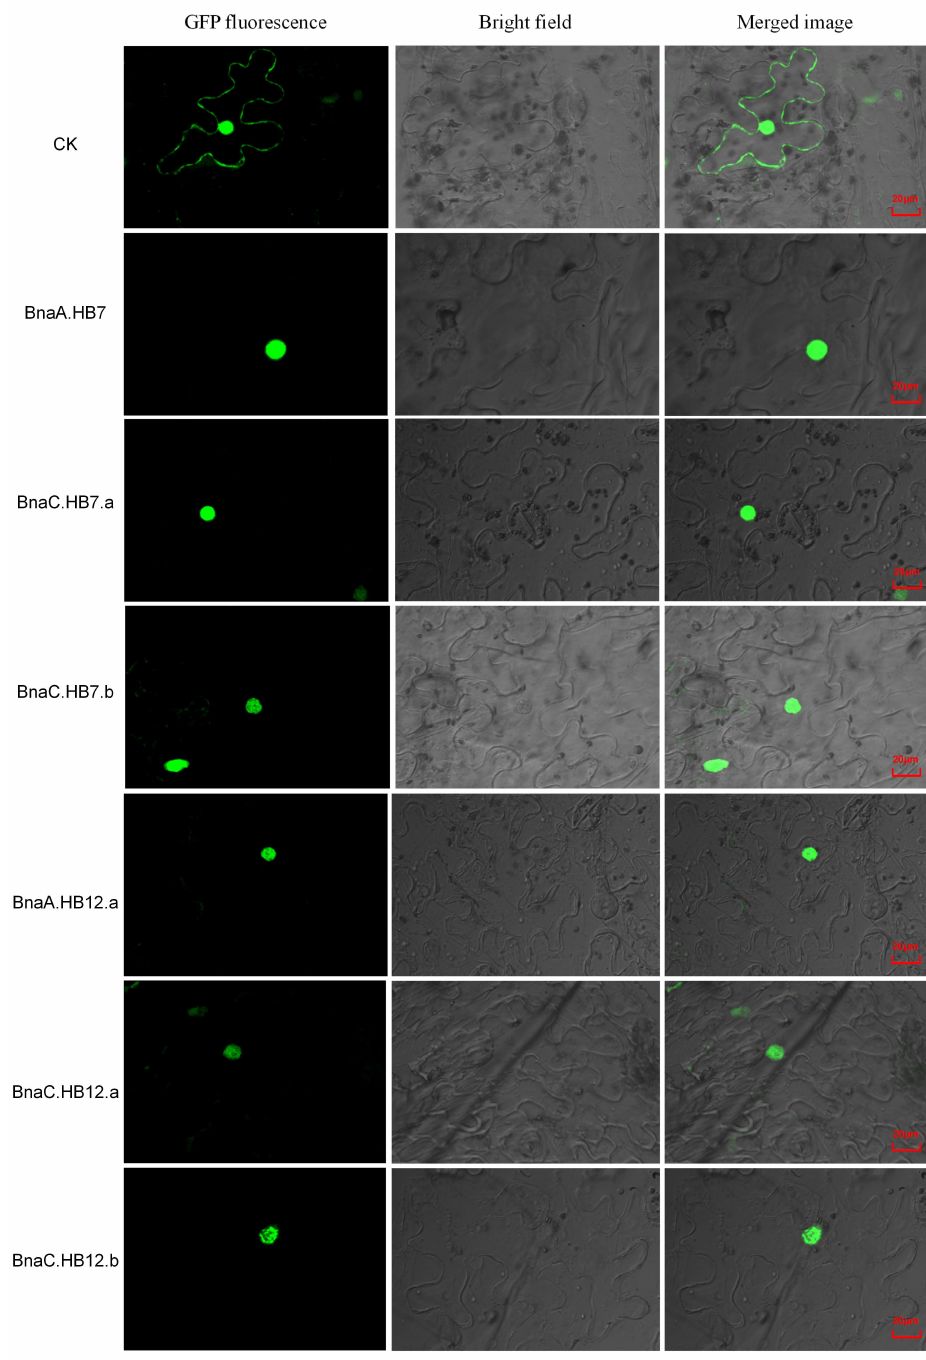
Figure 7. Subcellular localization of six BnHD-Zip proteins. Green fluorescence images were taken in a dark field, while the outline of the cell was taken in a bright field. CK: 35S: GFP represents the